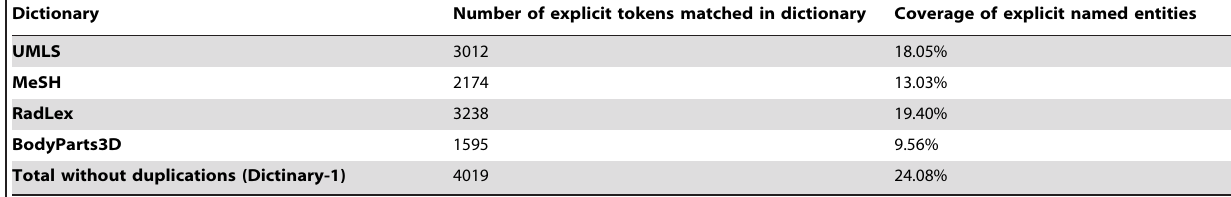
Table 4. Numbers of entities in